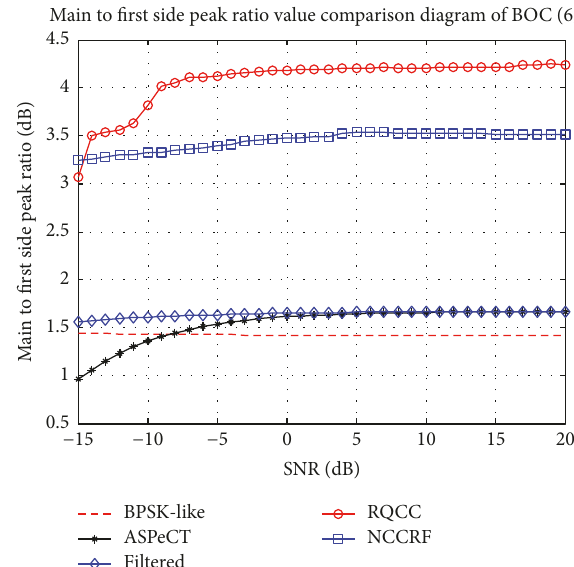
Figure 10: The MSPR comparison of BOC ( 6, 1 ).